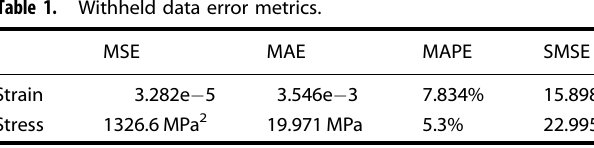
Error metrics for the trained fGP strain and stress models on the withheld grain data set. MSE mean squared error, MAE mean absolute error, MAPE mean absolute percent error, SMSE standardized mean squared error 68